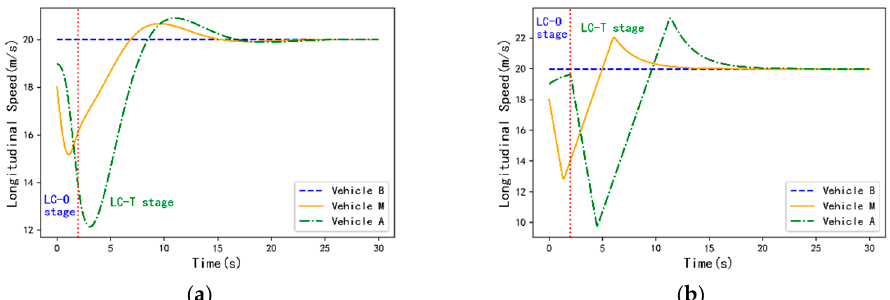
Figure 11. The longitudinal positions of vehicles B, M, and A of the two control strategies in scenario 2. ( a ) The proposed CLC control strategy, ( b ) CACC_Sine control strategy.